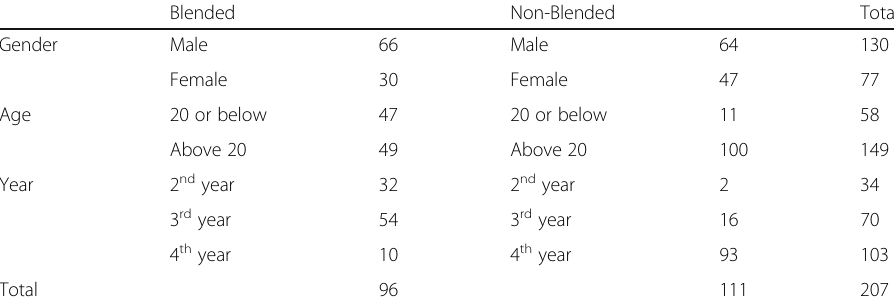
Table 4 Demographic details of respondents